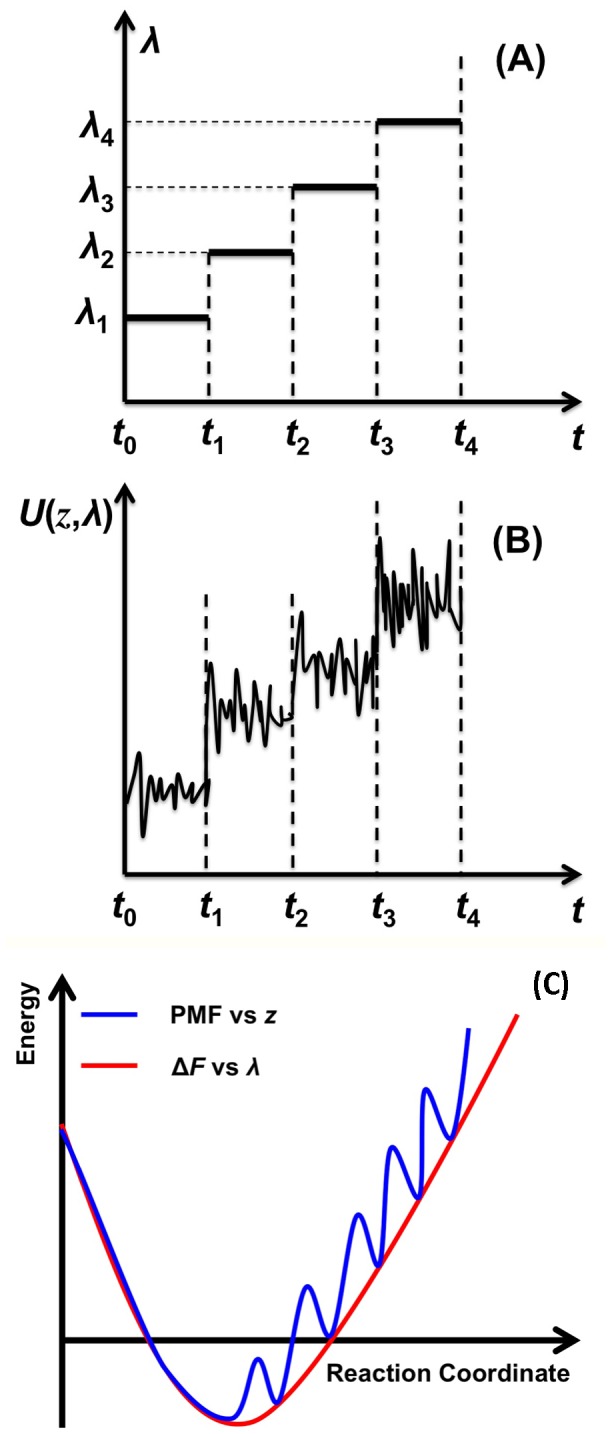
Schematic diagram for a step-wise pulling protocol.(A) Control parameter λ, and (B) expectation value of an applied potential versus time, U(z, λ) = k(z–λ)2/2. Coordinate z is the position of an ion along the z-direction. The pulling in the direction of increasing λ is called forward; the opposite direction of pulling is called backward. (C) Comparison between profiles for PMF (blue) and free energy changes (red) computed using our method.